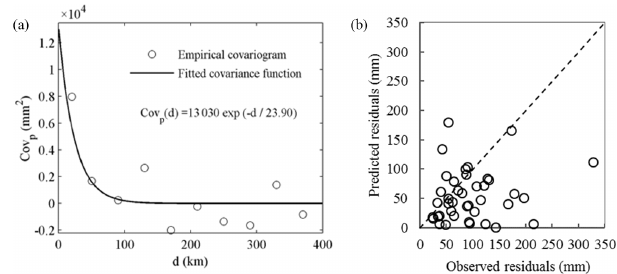
Figure 5. (a) Empirical covariogram (Cov e (d) ) from the residual R s (x) and theoretical covariogram by the fitted covariance function Cov p (d) of the study area. (b) The scatterplot of the predicted vs. observed